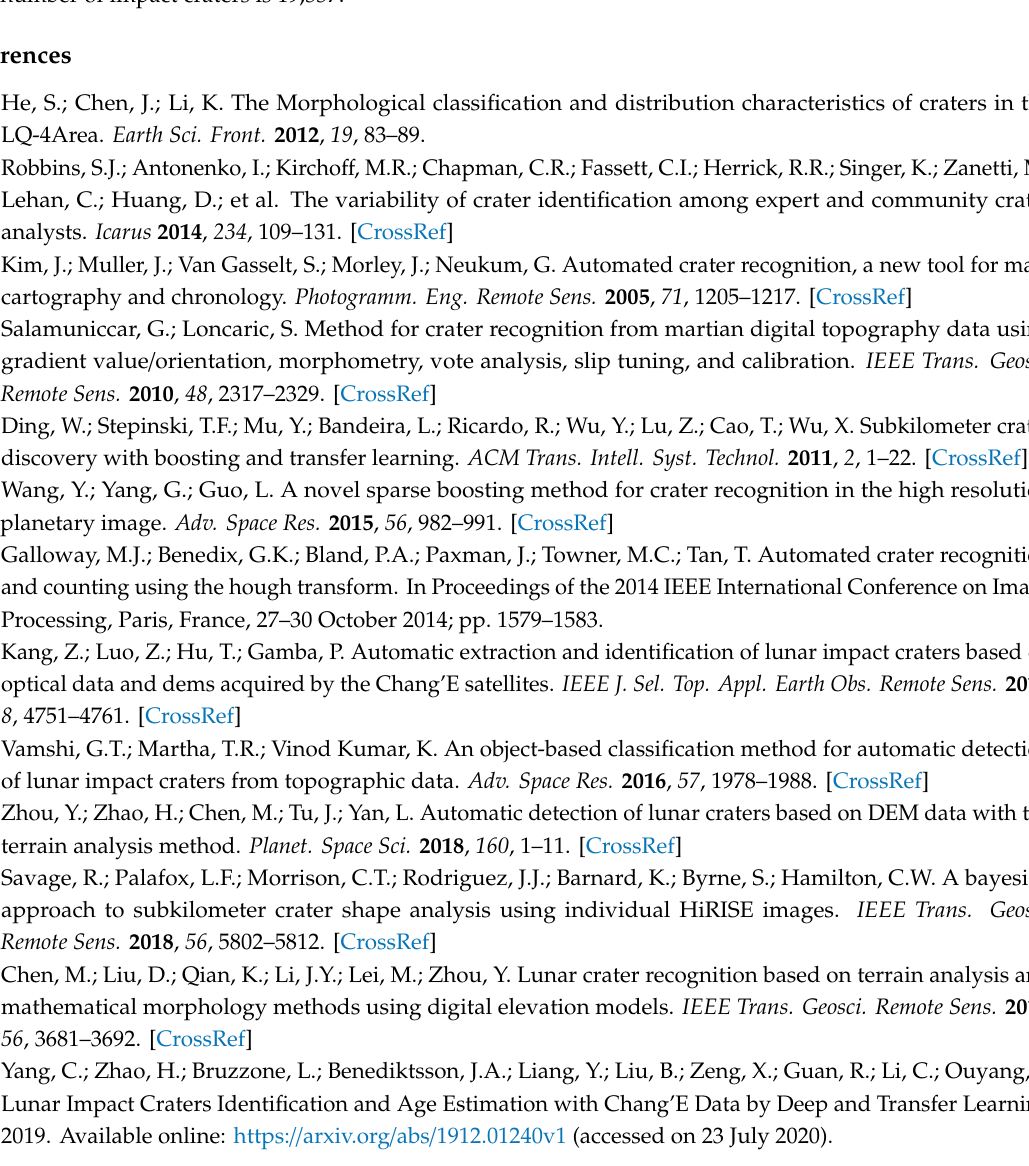
Figure A3. Distribution of small lunar craters (radius < 20 km) made by Povilaitis [26]. The total number of impact craters is 19,337.